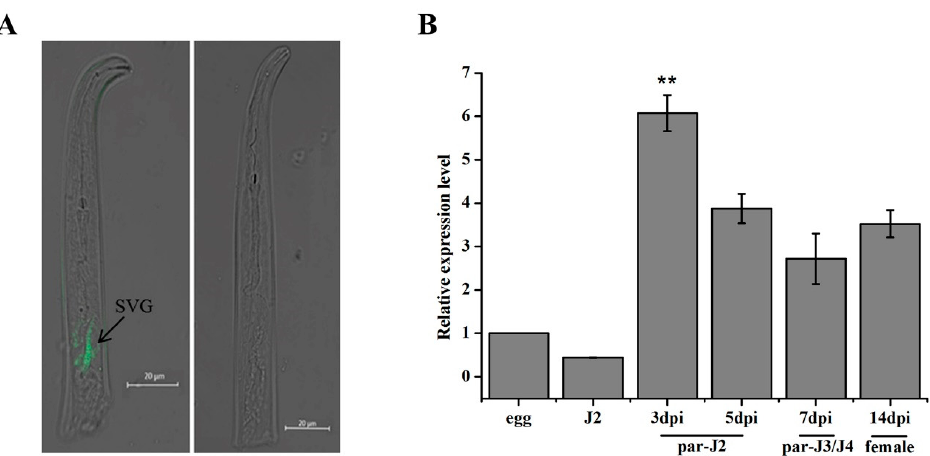
Figure 2. Expression patterns of MgPDI2 in M. graminicola . ( A ) Localization of MgPDI2 by in situ